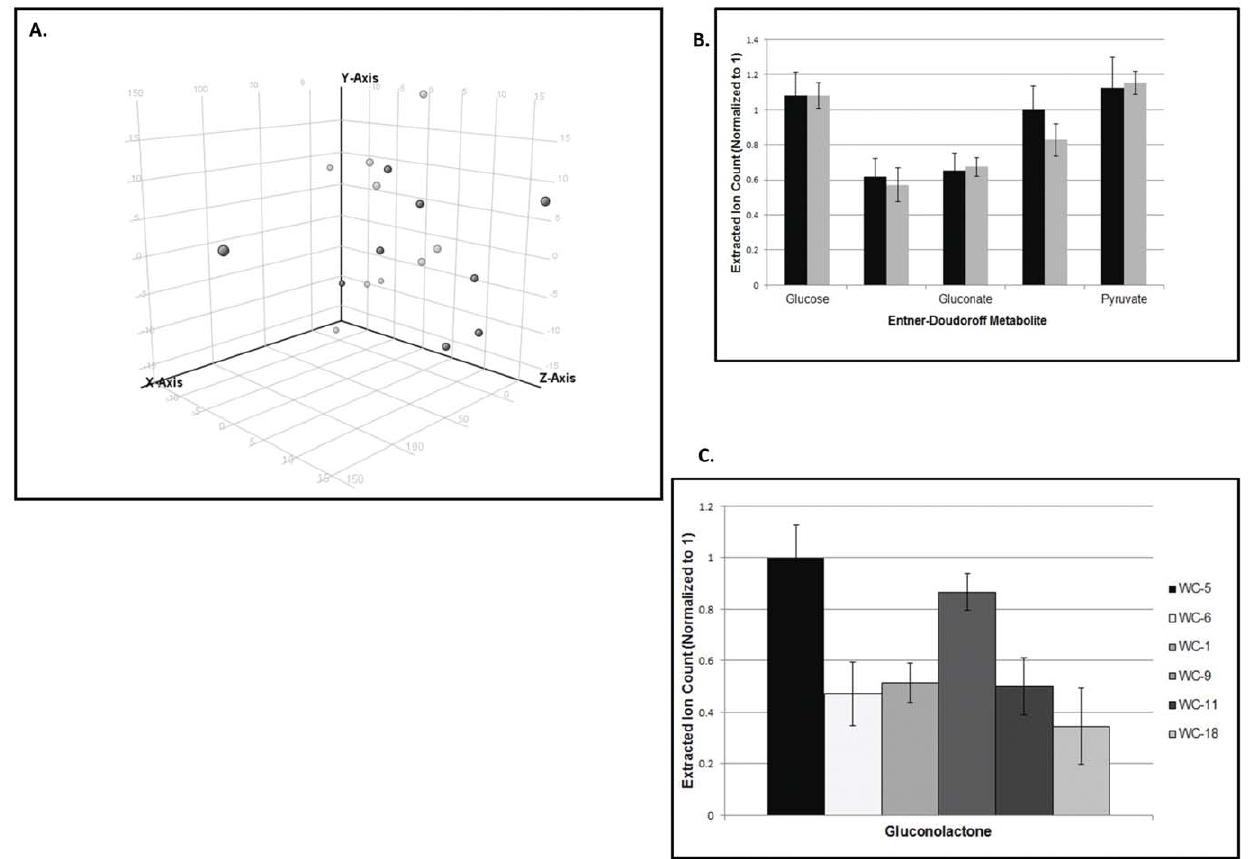
Figure 3. Metabolomic Analysis of Prevalent Endemic and Sporadic A.baumannii Isolates. ( A ) Principal components analysis of prevalent endemic (black circles) and sporadic (gray circles) isolates (in which the metabolomic profile of each isolate is represented as a single point on a 3-D axis) shows significant overap, consistent with similar metabolic profiles. ( B ) Targeted analysis of intermediates of the Entner-Doudoroff (ED) pathway shows no change in abundance of ED metabolites in sporadic (gray) vs prevalent endemic (black) isolates. ( C ) Abundance of gluconolactone (a representative intermediate in the ED pathway) did not differ significantly between sporadic isolates (WC-1, WC-5, and WC-6) and prevalent endemic isolates (WC-9, WC-5, and WC-6).